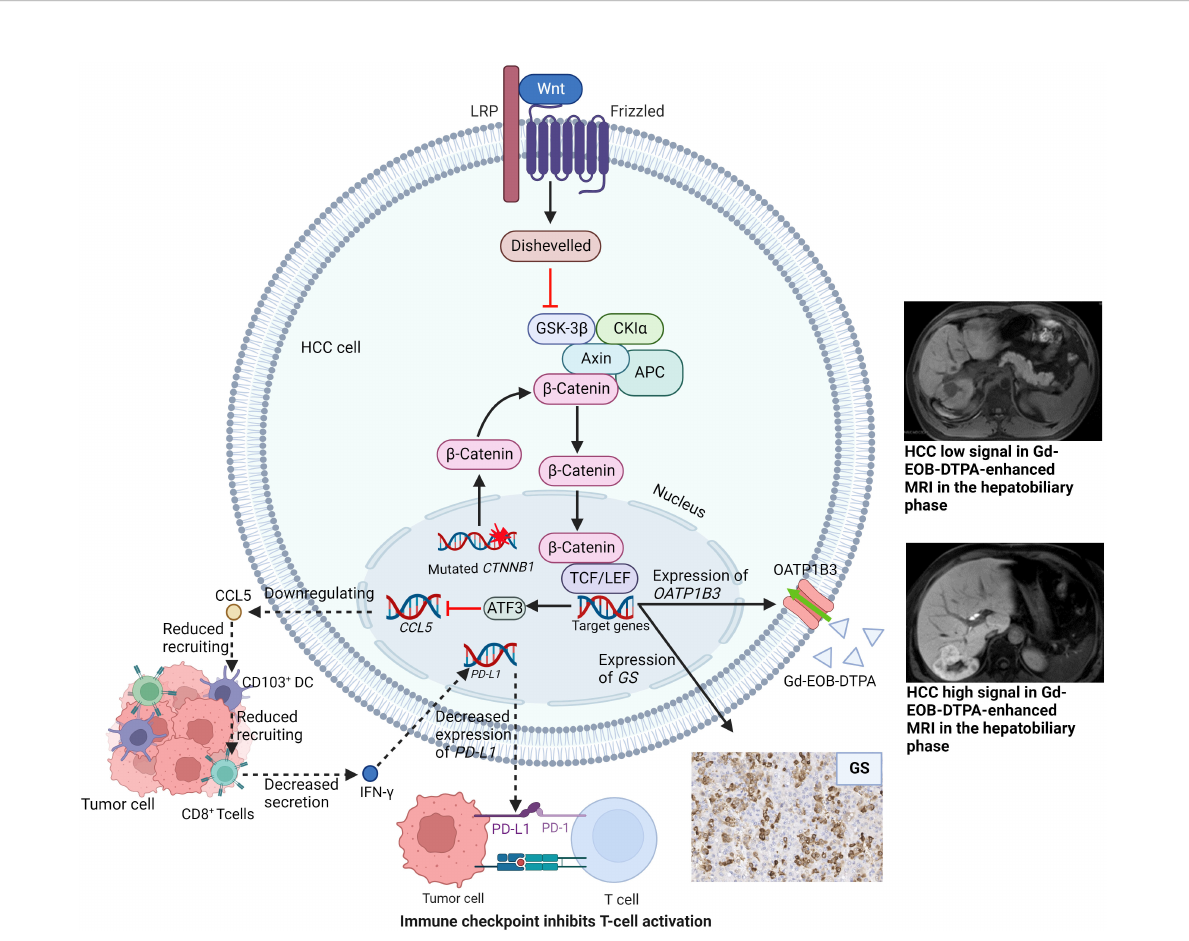
FIGURE 2 Wnt/ b -catenin signaling pathway with related target genes activated and subsequent manifestations. LRP, lipoprotein Receptor-Related Proteins; GSK-3 b , glycogen synthase kinase-3beta; CKI a , casein kinase I a ; TCF/LEF, T-cell factor/lymphoid enhancer factor; ATF3, activating Transcription Factor; CCL5, C-C chemokine ligand 5; DC, dendritic cells; IFN- g , interferon- g ; PD-1/PD-L1, Programmed death-1/programmed death-ligand 1; GS, glutamine synthetase; OATP1B3, organic anion transporting polypeptide